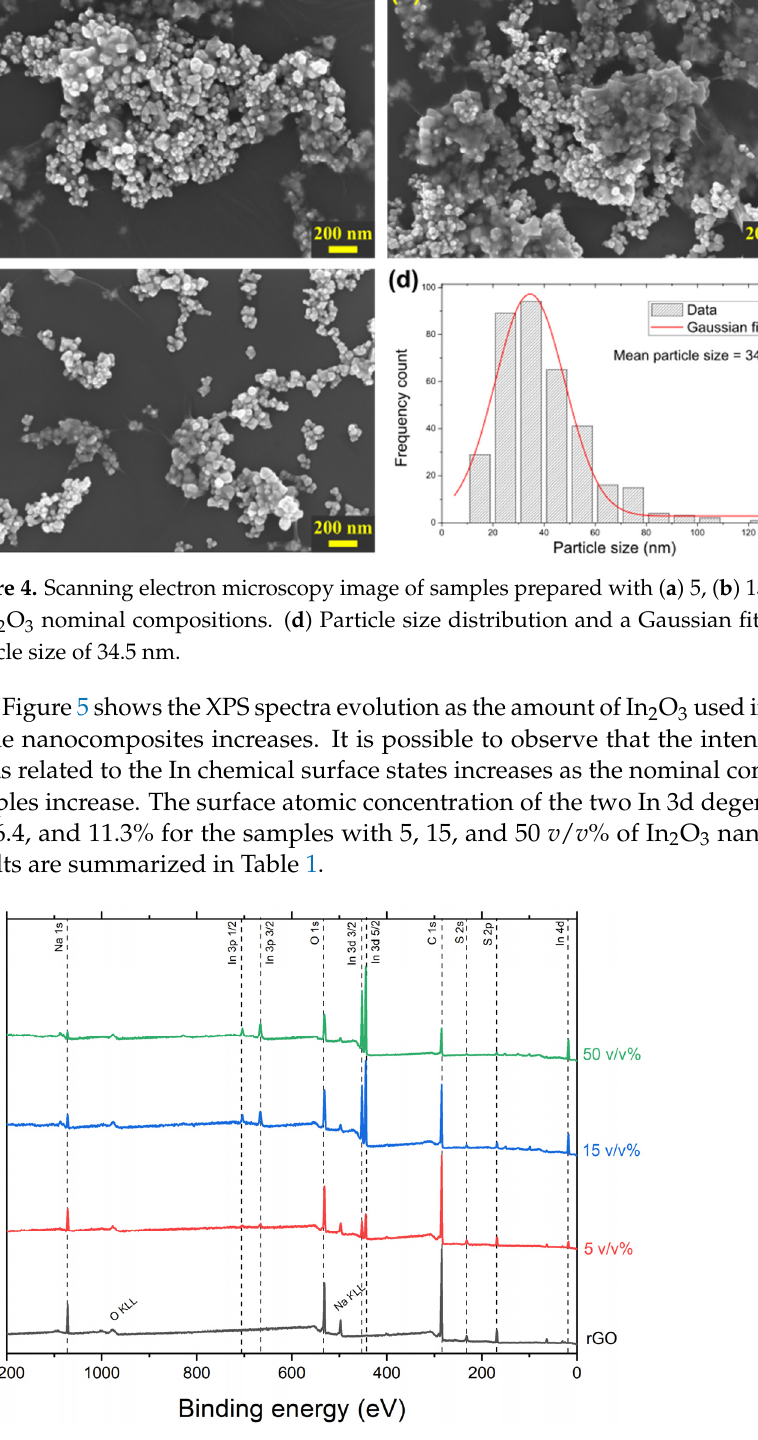
Figure 5. X-ray photoelectron spectra of the rGO and rGO-In 2 O 3 nanocomposites. Figure 6a–f present typical X-ray photoelectron spectra of the rGO and In 2 O 3 used in